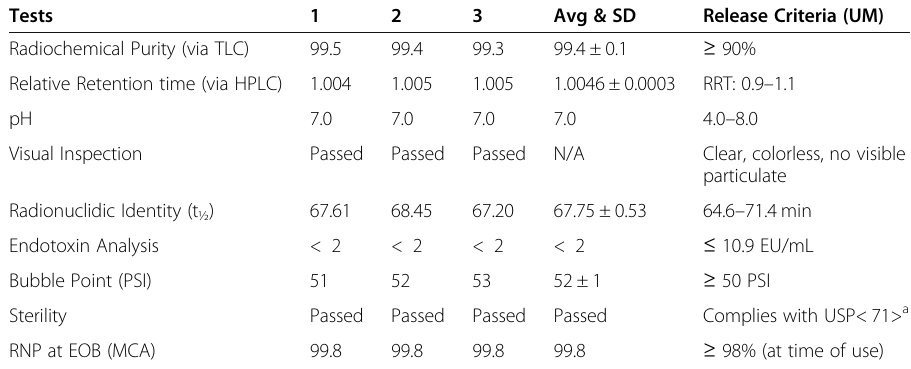
Table 8 Quality Control Data for three [ 68 Ga]Ga-PSMA-11 validation runs (UM)